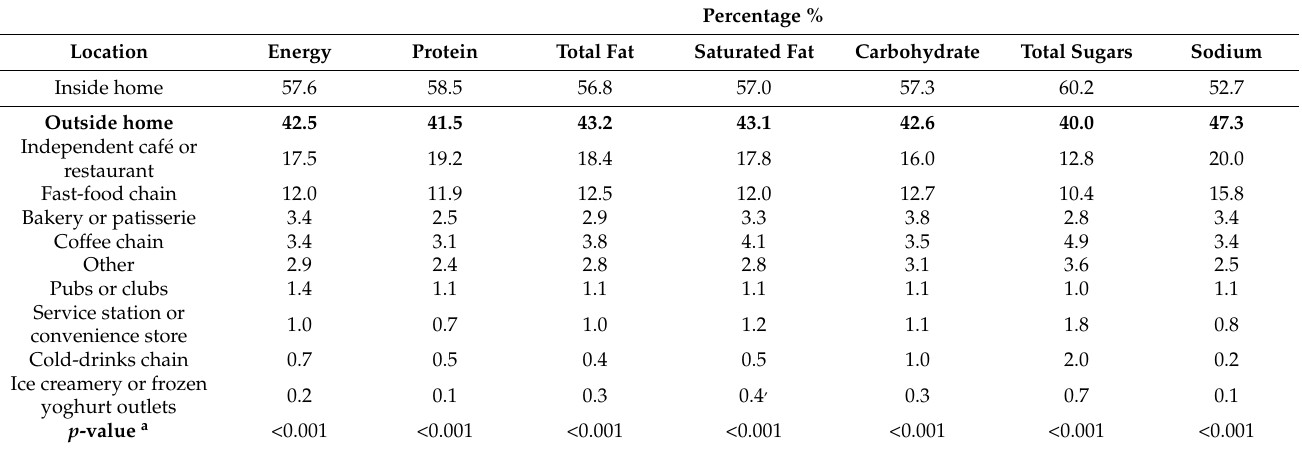
Table 1. Mean daily proportion of energy and nutrients contributed by foods prepared inside and outside of home and by different food outlet categories, across participants ( n = 1001). The outlets are listed in order of percentage contribution to energy.